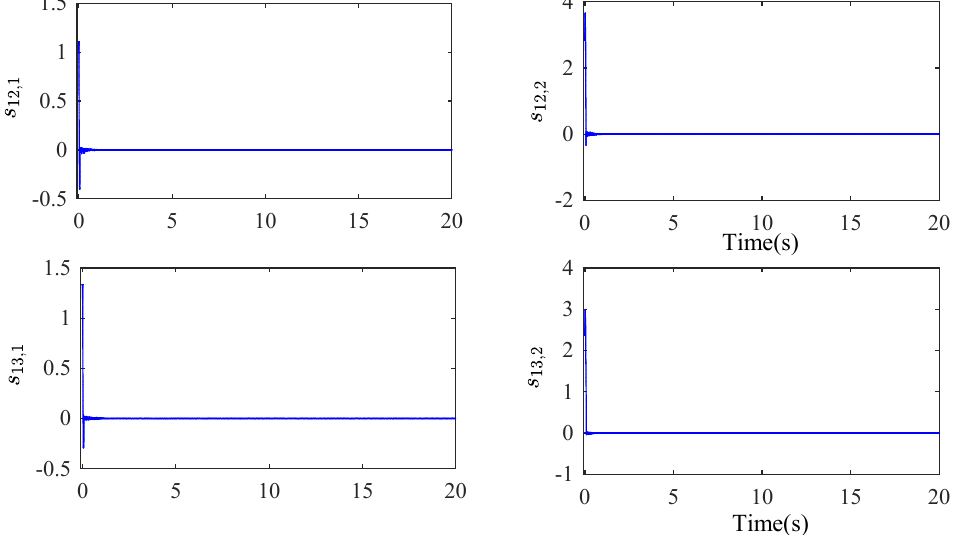
Figure 7. The sliding surface.